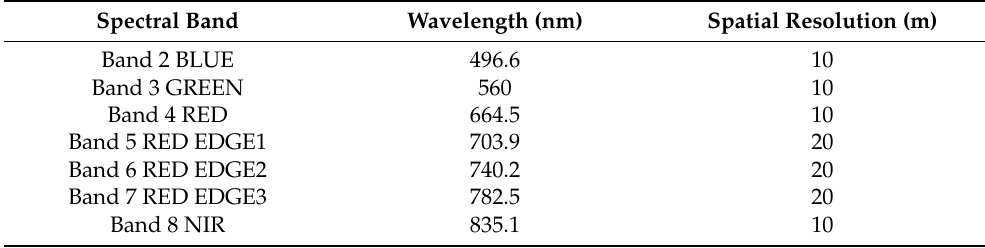
Table 2. Central wavelength and spatial resolution for the Sentinel-2 bands used in this